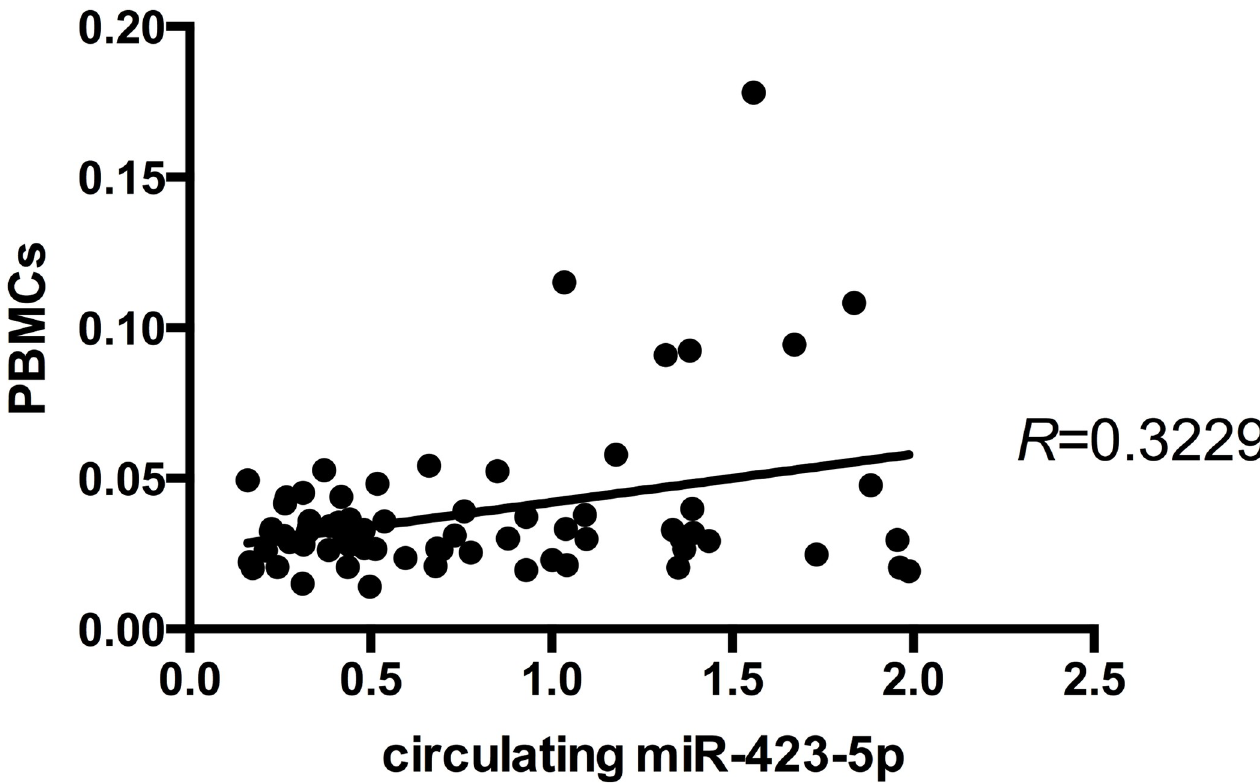
Fig 6. Pearson correlation. Pearson correlation scatter plot of plasma and PBMCs miR-423-5p (R = 0.3229; p = 0.006).